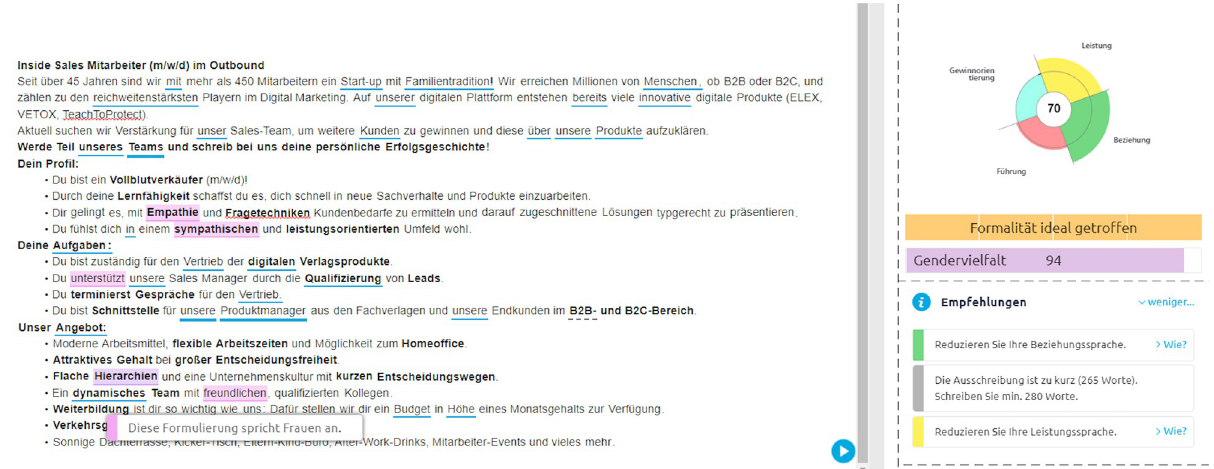
Fig 4. Graphical representation of a text analysis using the tool from 100W. A gender score slider is shown on the right. Words corresponding to different psychological profiles are highlighted in different colors [67].